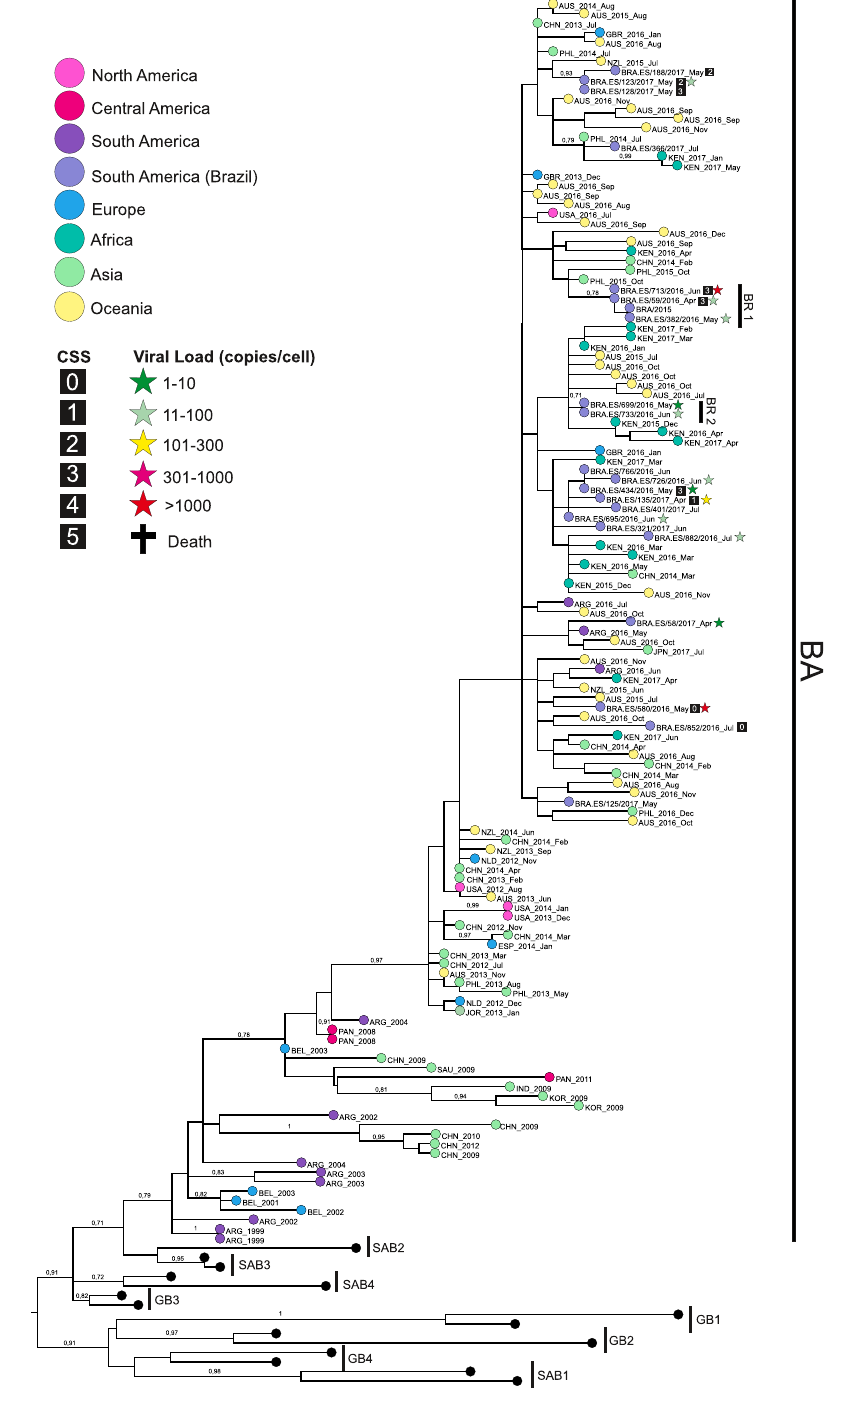
Fig 3. RSV-B phylogenetic tree. The tree was built using the maximum likelihood method on MEGA 6.0 software from a MUSCLE alignment of G gene sequences of 726 bp. Previously published sequences from known genotypes were retrieved from the NCBI database. Numbers from 1 to 5 within the squares indicate the patients’ CSS. The cross indicates patients who died due to RSV infection. The stars indicate the viral load, categorized by color (in copies per